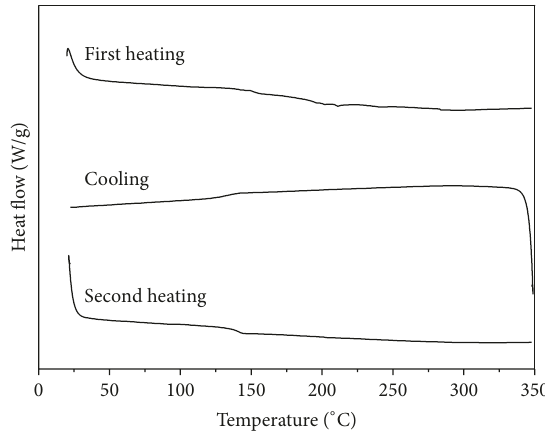
Figure 2: DSC traces of the Topas 6013